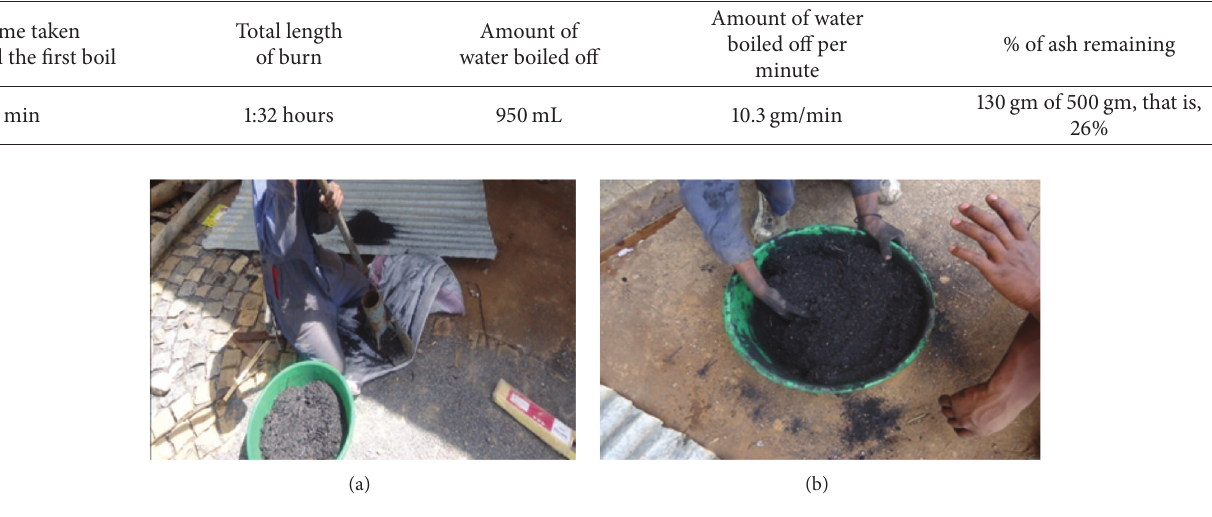
Figure 3: (a) Crushing the carbonized sesame stalks. (b) Charcoal and clay mixing.